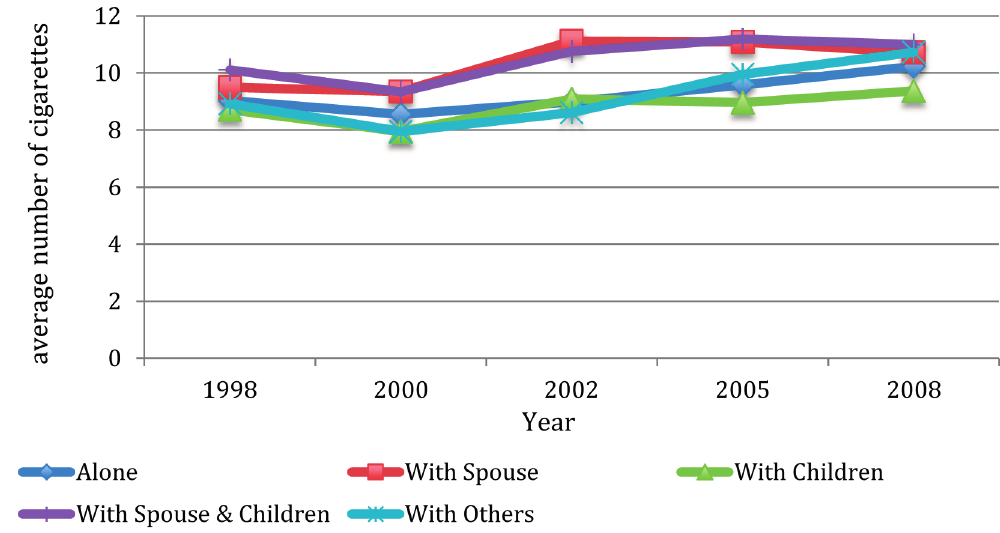
Figure 3. Average number of cigarettes smoked per day among current smokers by wave and by living arrangement.